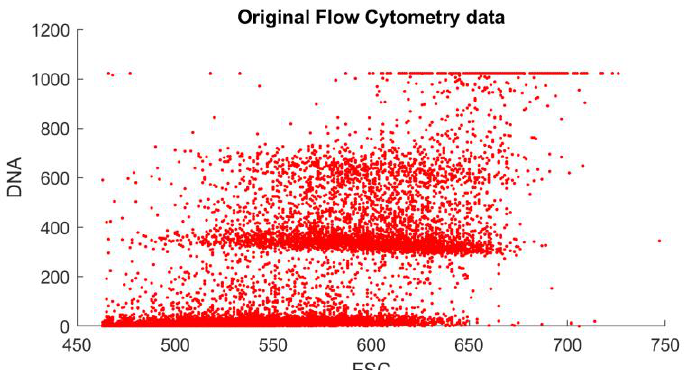
Figure 3. Flow cytometry data on a DNA content – object area scatterplot. Each data point represents a cell nucleus. The units of both axes are intensity-based: on the y -axis is the DNA content; on the x -axis is the forward scatter (a value proportional to the object size). The two populations of the 2N and 4N peaks are identifiable from looking at the y -axis.